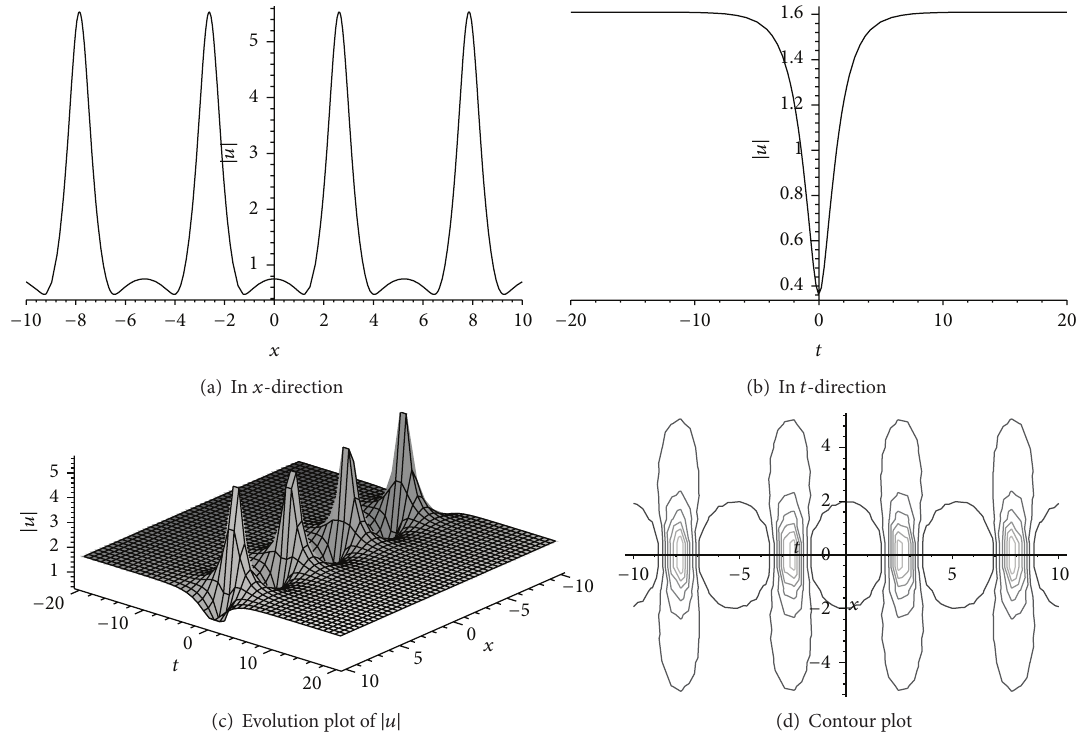
Figure 3: The periodic-solitary wave solution 𝑢(𝑥,𝑡) given by (27) with 𝛿 = 0.4 , 𝛽 = 2.0 , 𝜆 = 1.2 , and 𝑚 = 0.8 .